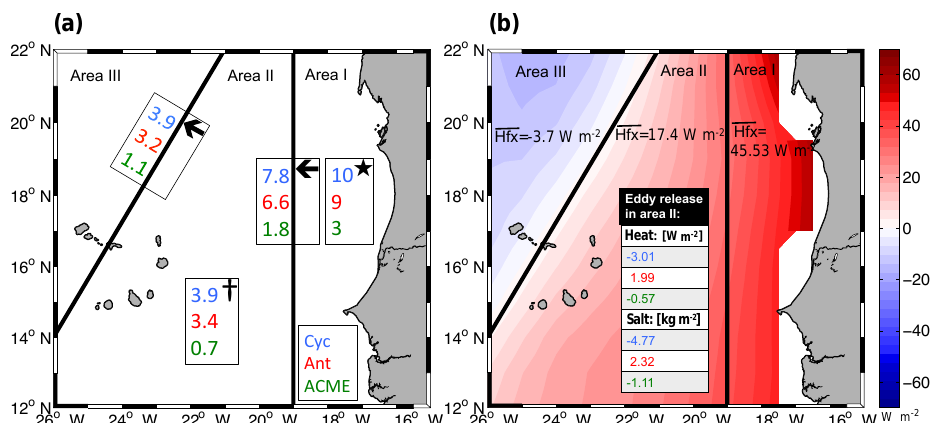
Figure 14. (a) Map of the TANWA divided into three areas (area I: the extended boundary current region, area II: the transition zone, and area III: the subtropical gyre region). Numbers inside of the boxes are the numbers of eddies (blue: cyclones, red: anticyclones, green: ACMEs), which are generated (star) and cease (cross) in an area or propagate from one area into another (arrow). (b) Annual mean net heat flux from NOC Surface Flux Dataset (colors) with three areas marked. Black numbers are the area-averaged net heat fluxes ( Hf x) in the corresponding areas. The table includes the eddy-type dependent (blue: cyclones, red: anticyclones, green: ACMEs) heat and salt release in area II.